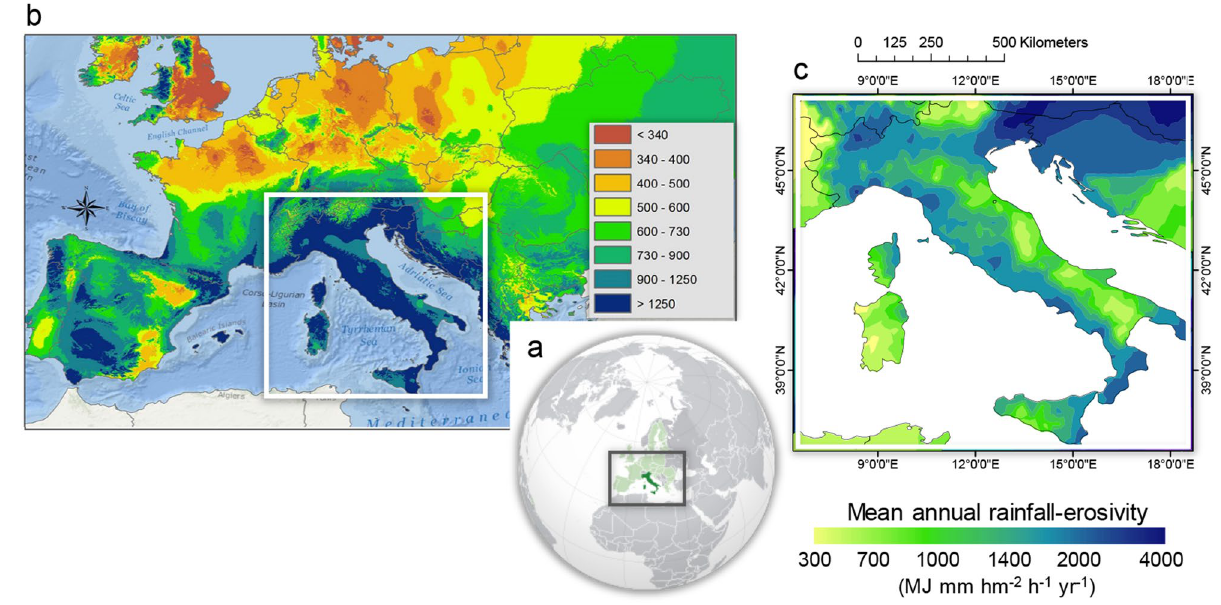
Figure 1. Study area. ( a ) Environmental setting. ( b ) Spatial pattern of mean annual rainfall erosivity (MARE) over central-southern Europe. ( c) Map of MARE over Mediterranean Central Area for the period 1994–2013 (arranged with Geostatistical Analytics by ArcGIS-ESRI on the ESDAC-dataset, https ://esdac .jrc.ec.europ a.eu/ conte nt/globa l-rainf all-erosi vity) 55